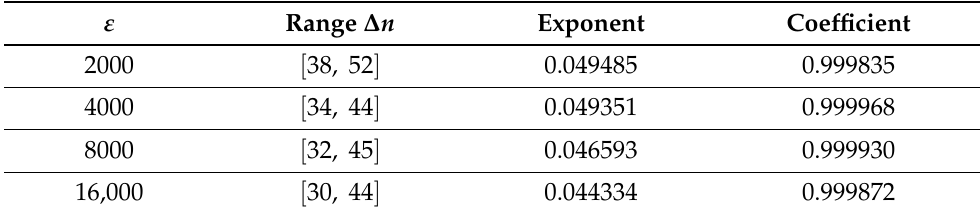
Table 3. Maximal Lyapunov exponents for coop2.